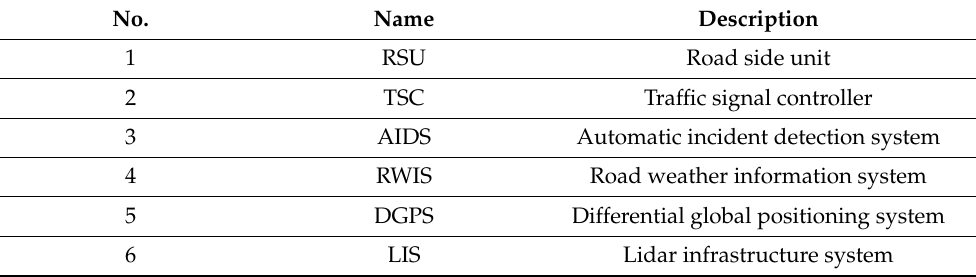
Table 15. V2X infrastructure list.